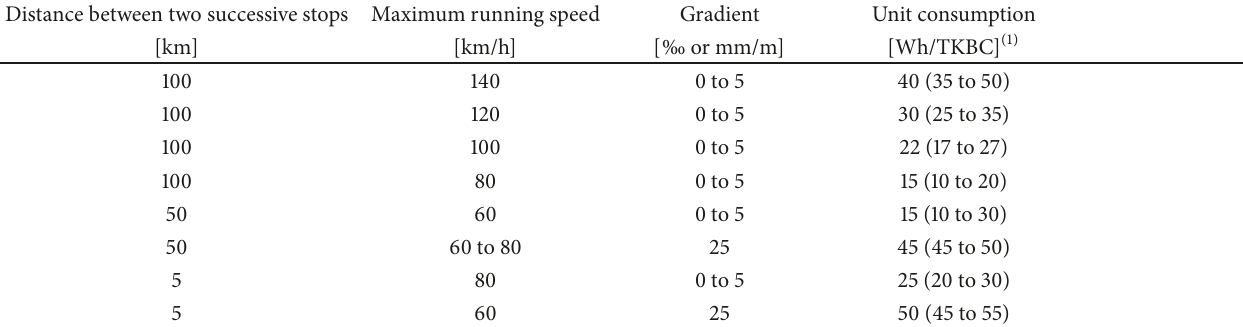
Table 1: Electric energy consumption, in Wh/TKBC (unit of measure: Wh/(t ∙ km)), according to the slope value. Source: Baumgartner [21]. Distance between two successive stops Maximum running